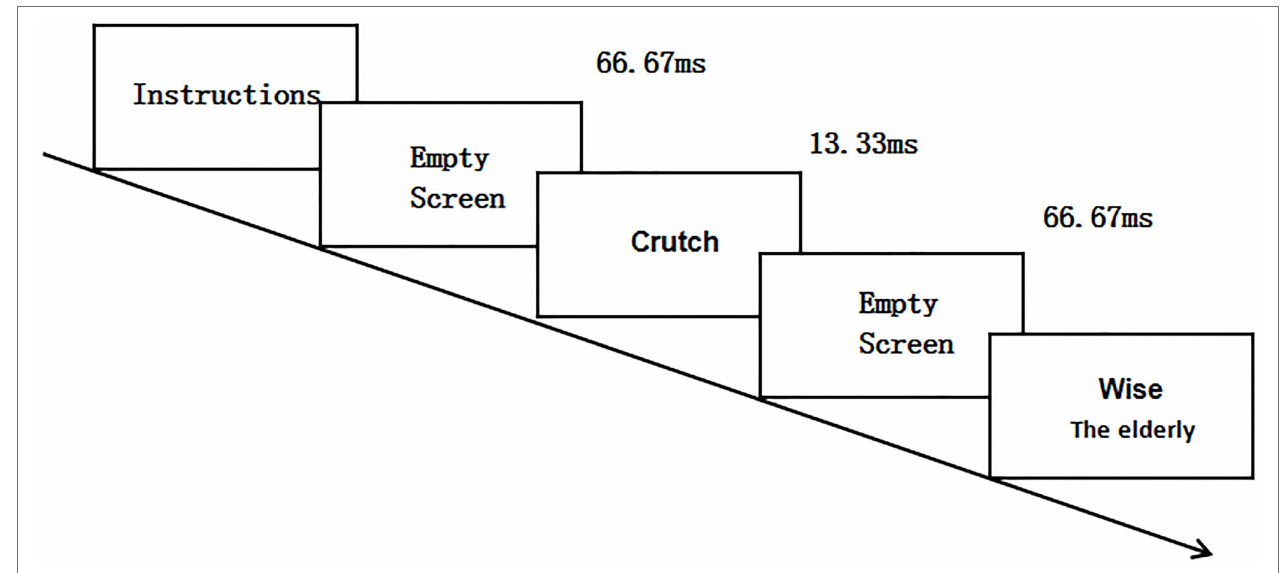
FIGURE 2 | Intervention training flow chart.